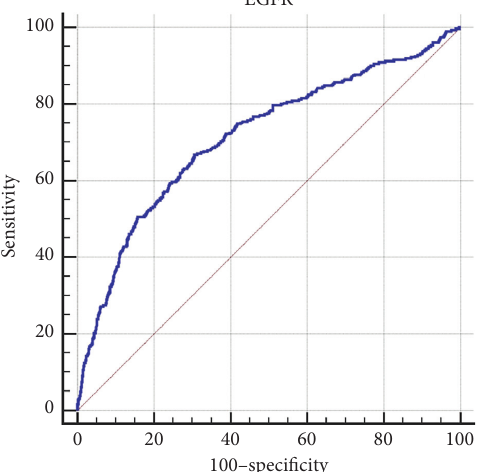
Figure 3: ROC curve for prediction of kidney injury based on eGFR is demonstrated. An eGFR below 62% could be defined as a cut-off point for predicting AKI development with intensive blood pressure